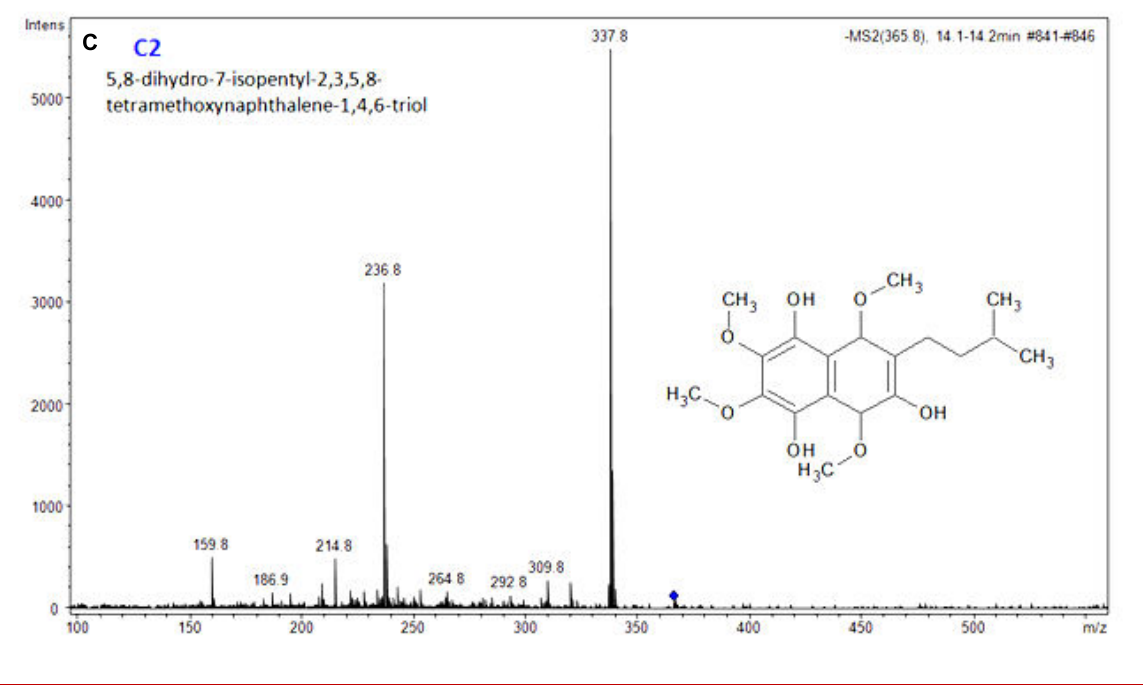
Figure 1: LC/MS/MS pattern for novel two active principles present in the aqueous extract of S. tetragonam (Continued)